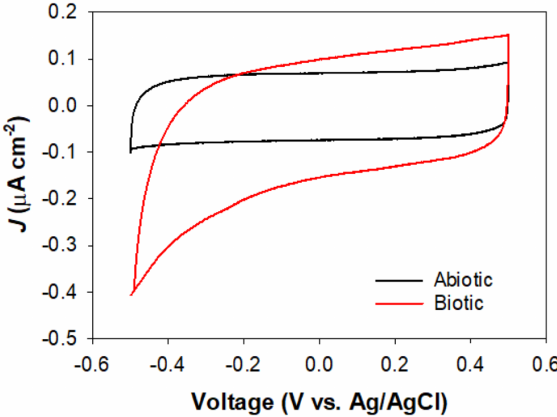
Figure 5. Cyclic voltammograms of the carbon electrode in the presence (biotic, red line) and absence (abiotic, black line) of Haematococcus pluvialis cells in a single-chamber electrochemical reactor with three electrodes. The scan rate was 10 mV s − 1